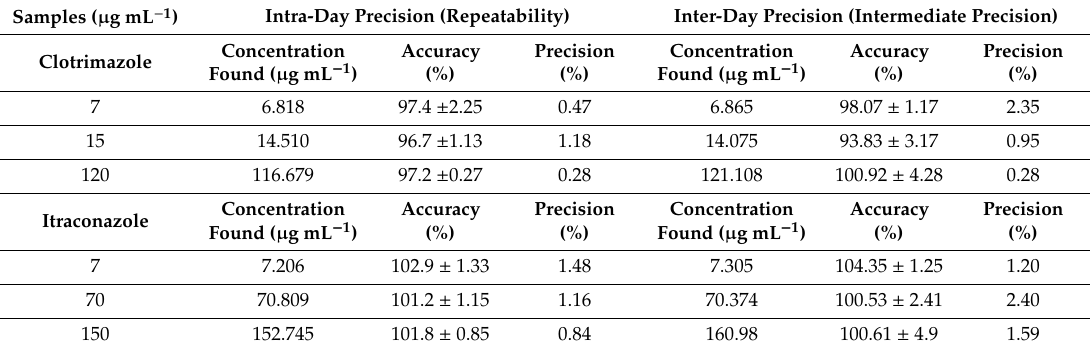
Table 4. Data related to the stability of the assay of the developed HPLC method. N = 2 for each day and